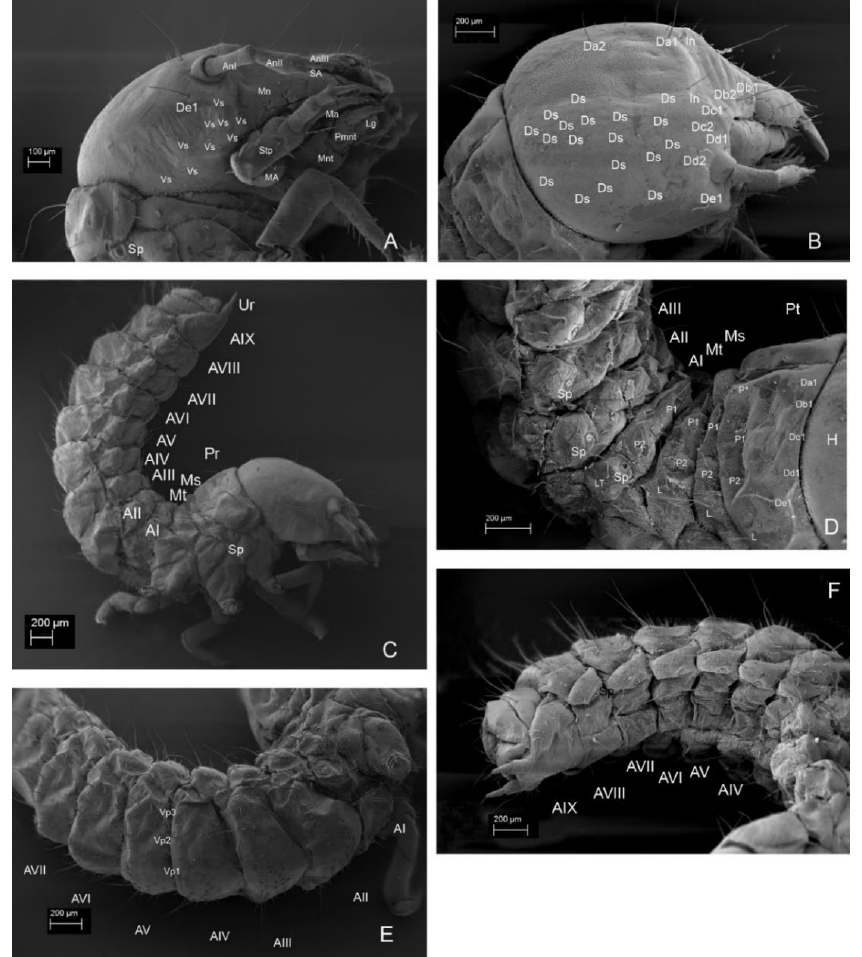
Figure 13. Leiodes cinnamomea . Details of larval morphology of instar II. ( A ) Head, ventro-lateral view. ( B ) Head, dorso-lateral view. ( C ) Body in lateral view. ( D ) Thorax and part of abdomen in dorso-lateral view. ( E ) Abdomen in ventral view. ( F ) Abdomen in dorso-lateral view. Abbreviations: